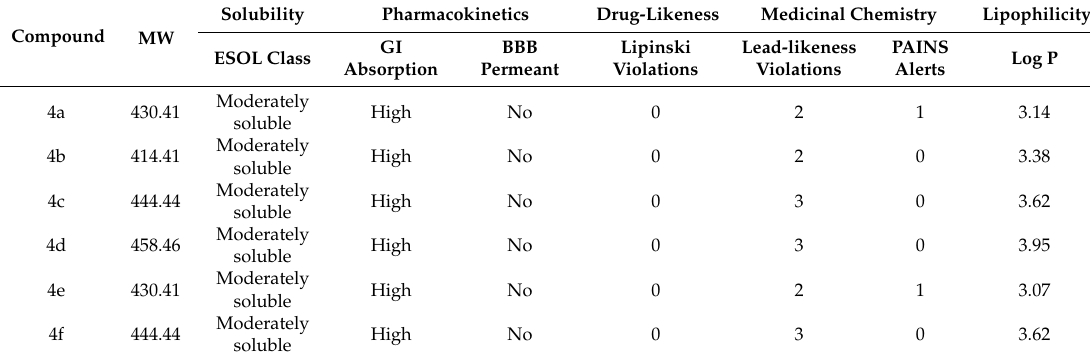
Table 1. Physiochemical properties of the compounds 4a – 4o collected from Swiss